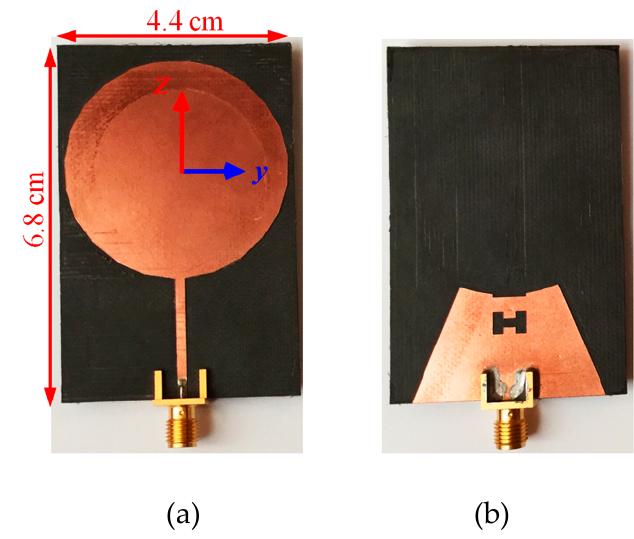
Figure 2. Fabricated single-port antenna: ( a ) top view; and ( b ) bottom view.